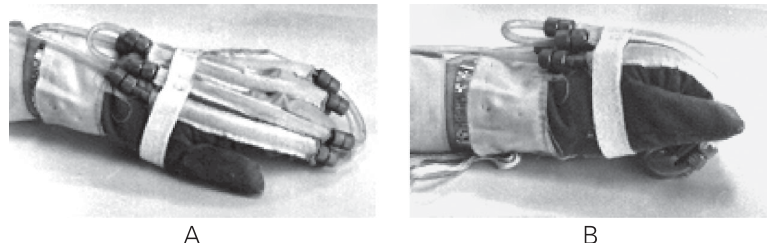
Figure 11. Shape memory alloy glove. A , Low temperature position. B , High temperature position. Taken from Ref. 32 (http://www.amtbe.com).